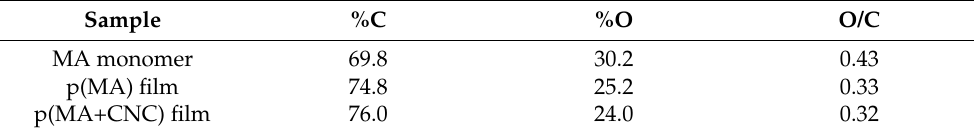
Table 1. XPS elemental composition (at.-%) of plasma-polymerized films (20 W, DC = 2%).